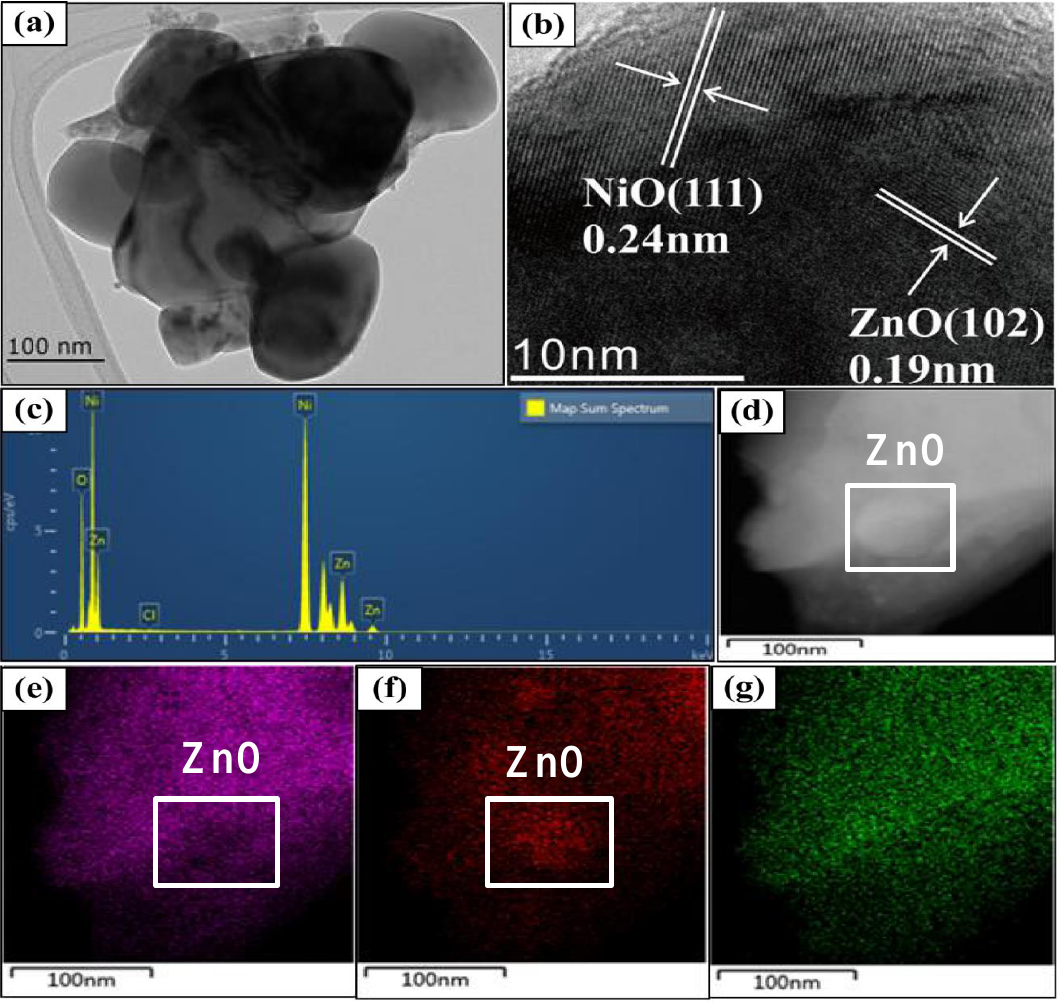
Figure 3. ( a ) TEM; ( b ) HRTEM; ( c ) EDS; ( d ) TEM-EDS dark-mapping scan; ( e – g ) TEM-EDS Ni, Zn and O color-mapping scans of ZnO–0.425NiO annealed at 550 °C.